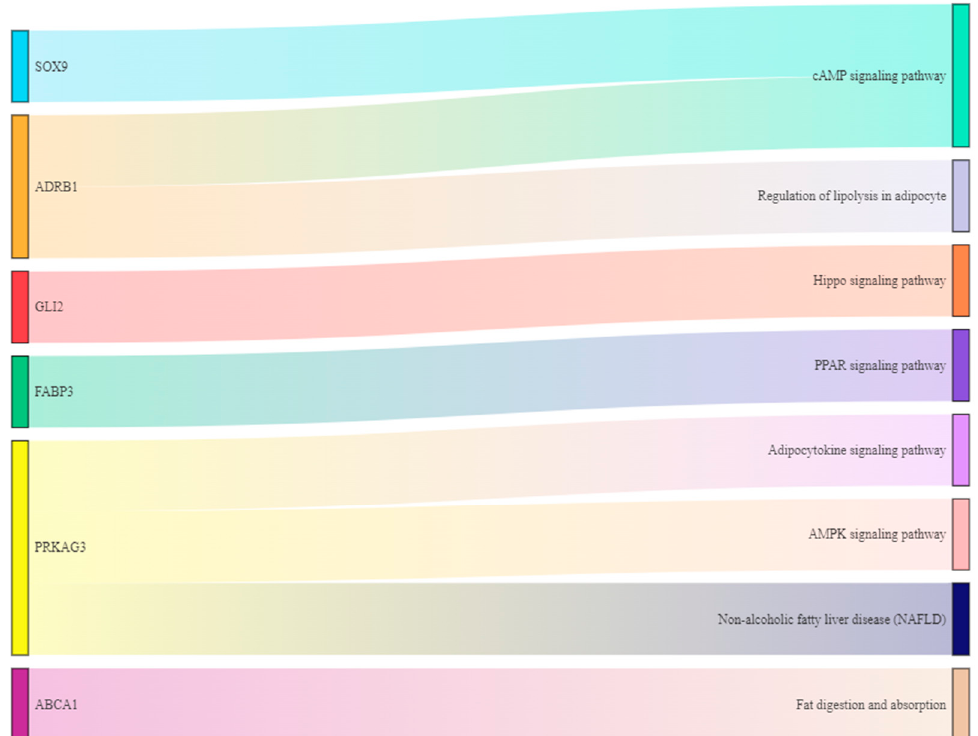
Figure 8. Association between genes and signaling pathways.